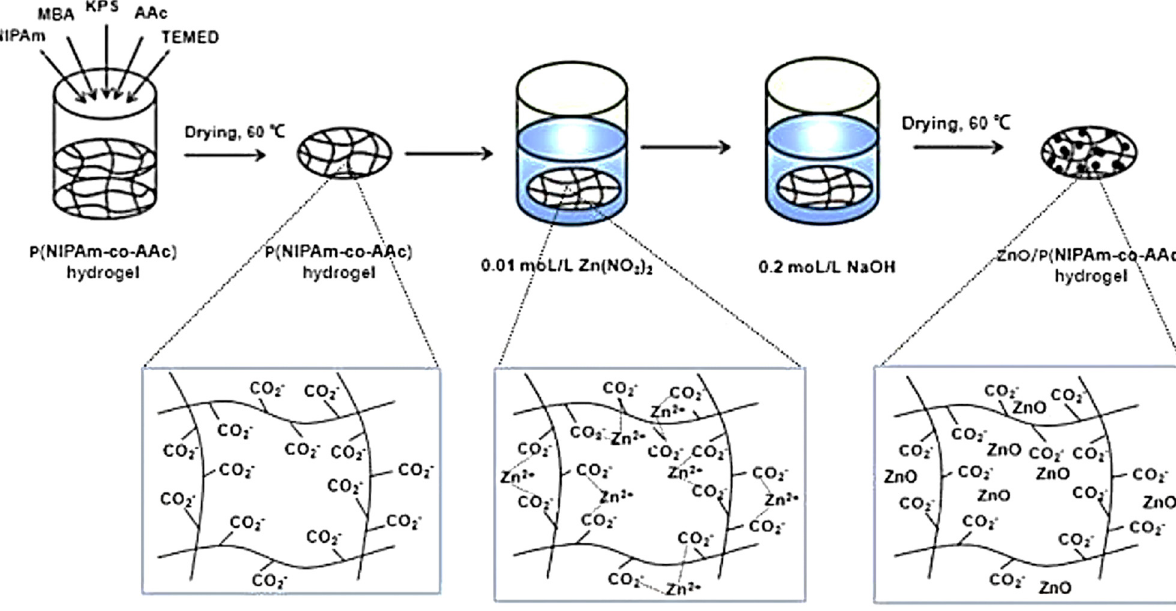
Figure 9: Preparation of the ZnO/poly ( N - isopropylacrylamide - co - acrylic acid ) hydrogel [ 177 ]